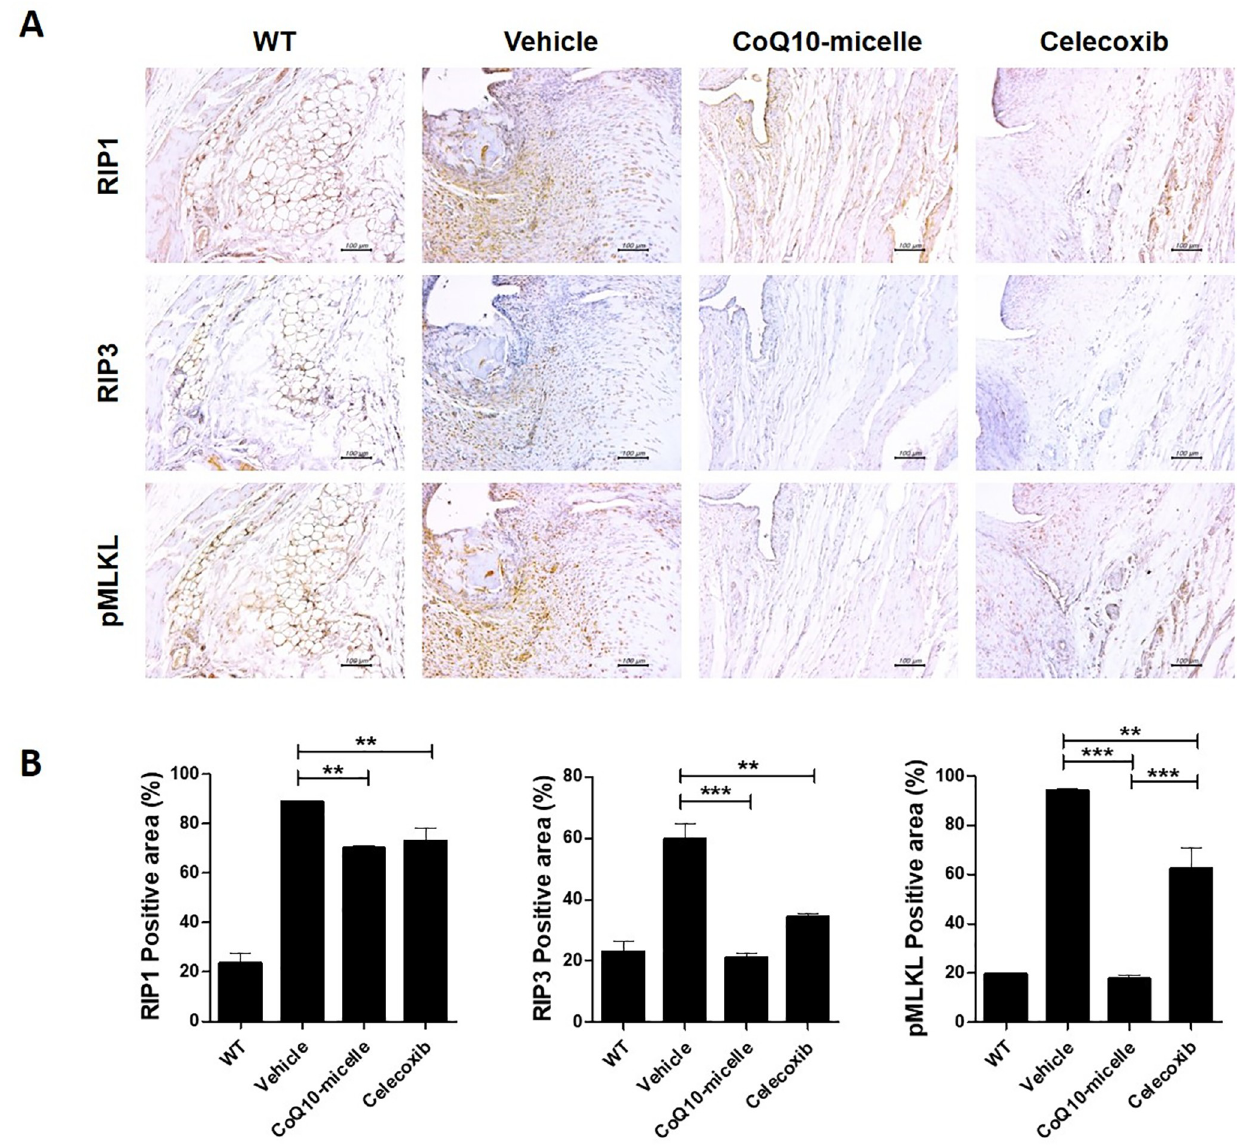
Fig 6. The effect of CoQ10-micelles on inflammatory cell death during OA progression. (A) Representative images of immunohistochemical staining of RIP1, RIP3, and pMLKL in the joint synovia of a WT group, a vehicle group, a CoQ10-micelle group, and a celecoxib group. (B) The bar graphs show the average positive areal percentages for RIP1, RIP3, and pMLKL. Data are shown as means ± S.E.Ms. Statistical significance was assessed using the Bonferroni test. � p <